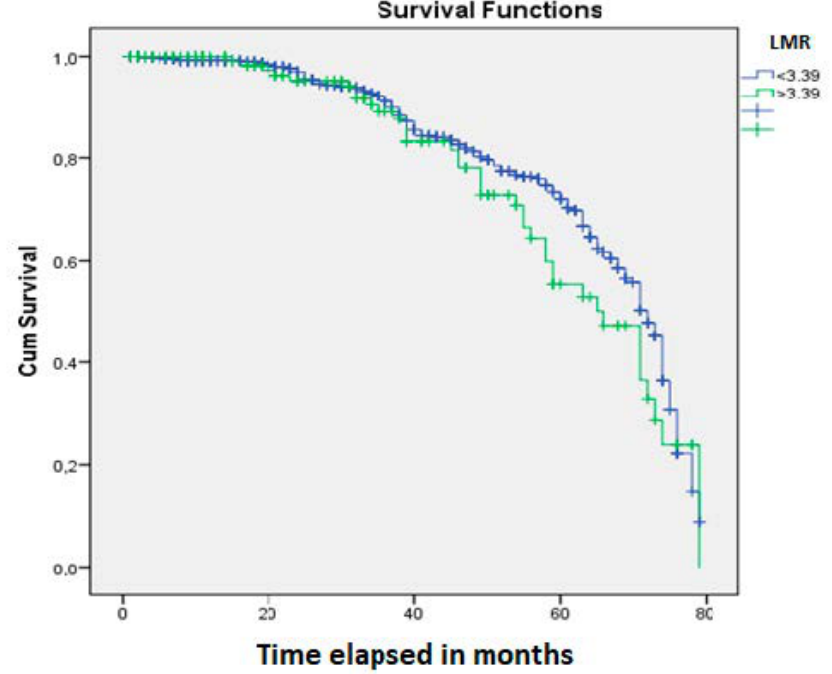
Figure 3. The cut-off value of 3.11 for the NLR can be used as an independent prognostic parameter for patients with rectal cancer ( p = 0.03).